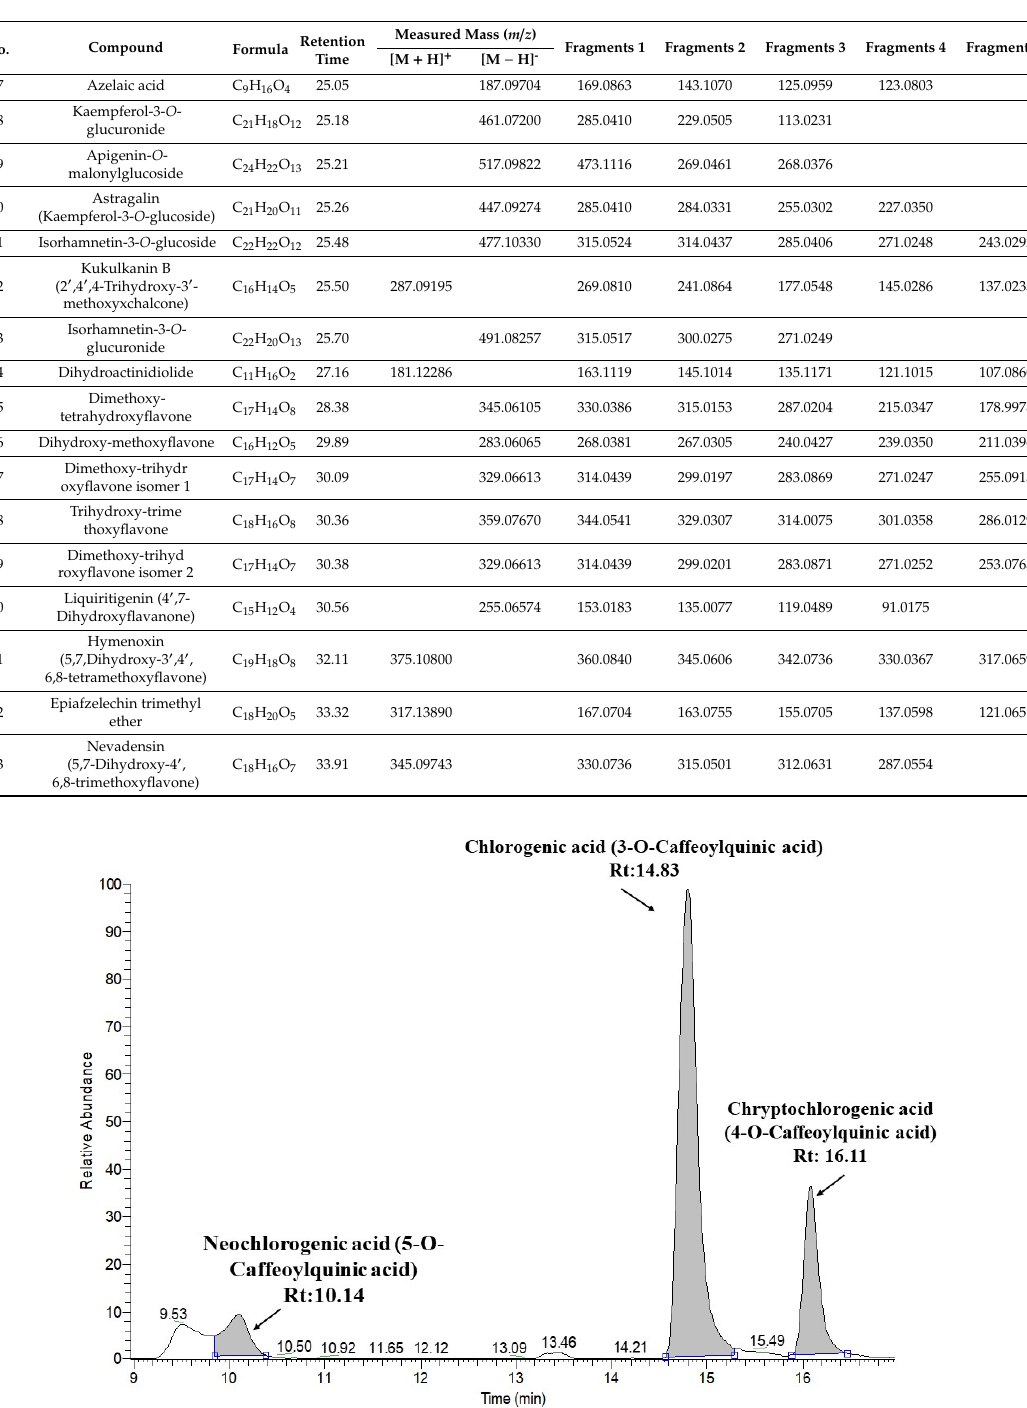
Figure 3. Extracted ion chromatogram of chlorogenic acid structural isomers. Among flavonoids, isorhamnetin-3- O -glucoside with m / z 477.1033, kaempferol 3-glucuronide Table 3. Chemical composition of Jerusalem artichoke leaf protein concentrate (JAPC) extracted from (kaempferol 3- O - β - d -glucopyranosiduronic acid) with m / z 461.0720, and astragaline (kaempferol green biomass. 3- O - β - d -glucopyranoside) with m / z 447.0927 was found in the JAPC. However, to our knowledge, this is the first time glucuronide derivatives of isorhamnetin (isorhamnetin-3- O -glucuronide) and isoquercetin (quercetin 3- O - β - d -glucopyranoside) with m / z 463.0877 (Table 3 and Figure 4) have been